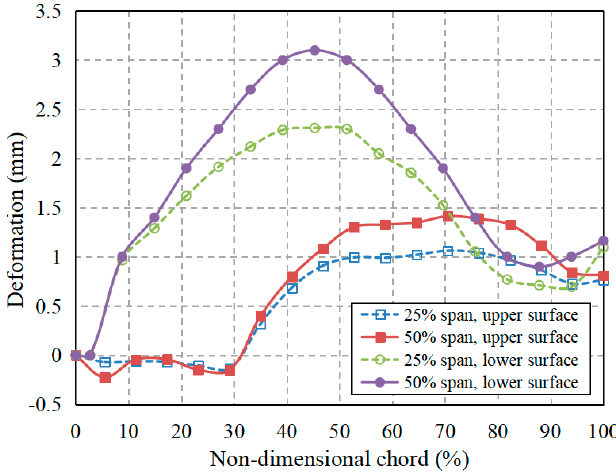
Figure 9. Deformation of 25% and 50% span section.